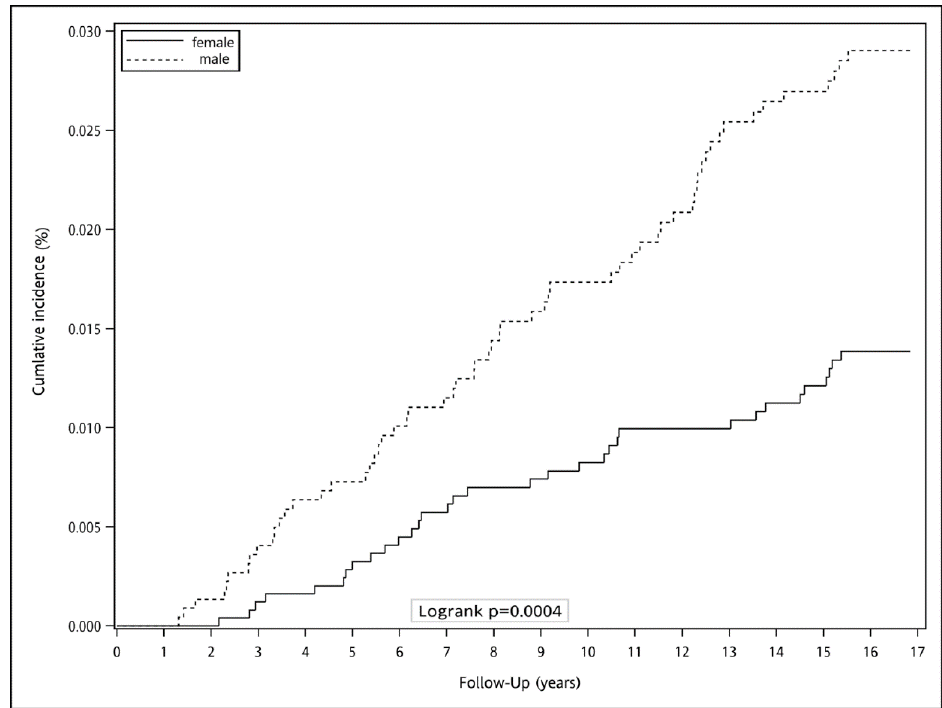
Figure 2. Cumulative incidence of colorectal cancer based on gender.